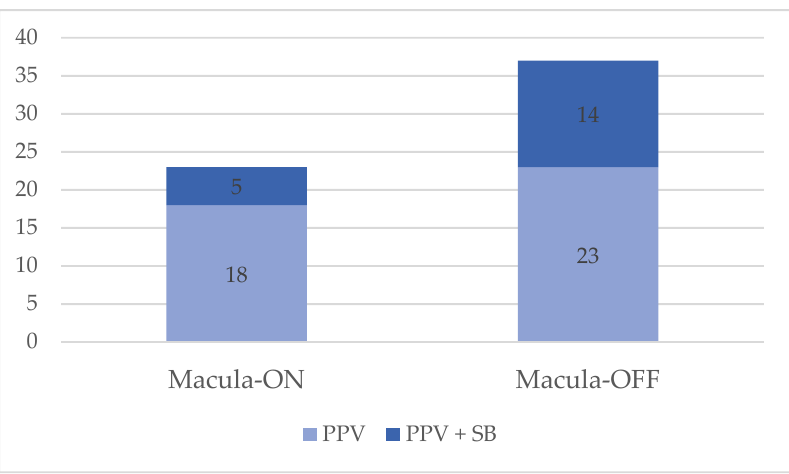
Figure 3. Macular status prior to surgery and type of surgery. Abbreviations: PPV, pars plana vitrectomy; SB, scleral buckling.